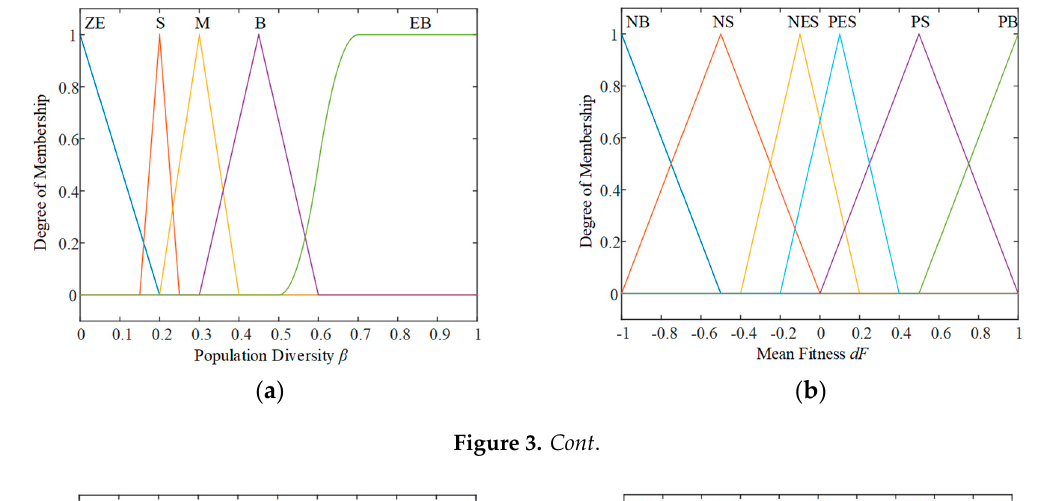
Energies 2020 , 13 , x